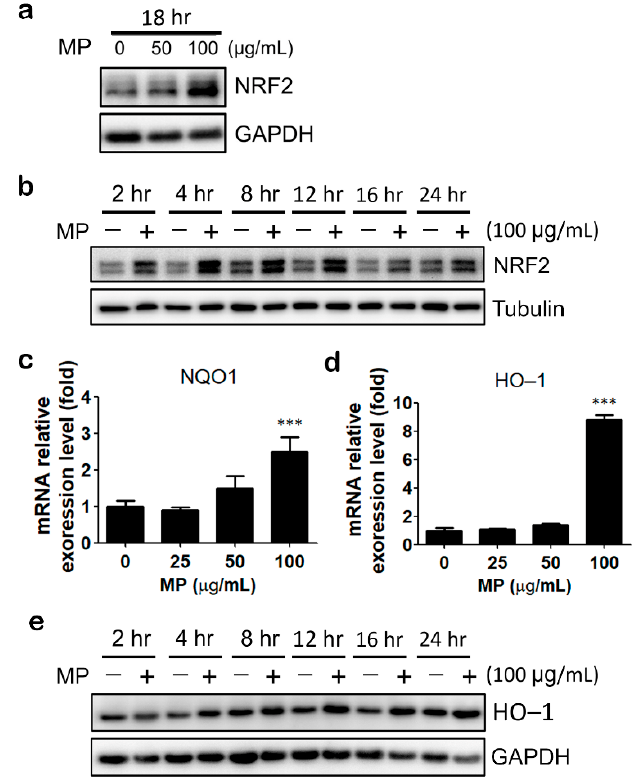
Figure 2. MP fraction activated NRF2 signaling pathway in HaCaT cells. ( a ) HaCaT cells were treated with MP fraction for 18 h. Cells were harvested for immunoblot analysis. ( b ) HaCaT cells were treated with MP fraction treatment for 2 to 24 h. The protein expression level of NRF2 was determined by immunoblot. ( c , d ) HaCaT cells were treated with MP fraction for 18 h for QPCR assay. DMSO solvent control was used as 1. Data are expressed as normalized mRNA levels and presented as mean ± SD. ( e ) HO-1 protein expression was determined by immunoblot following MP fraction treatment for 2 to 24 h. The asterisk (*) indicates a significant difference from the solvent control cells. (*** p < 0.001, one-way ANOVA).